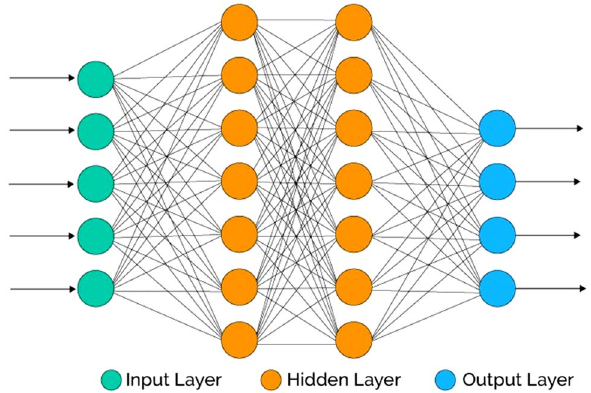
Fig. 14 The general configuration of an MLP